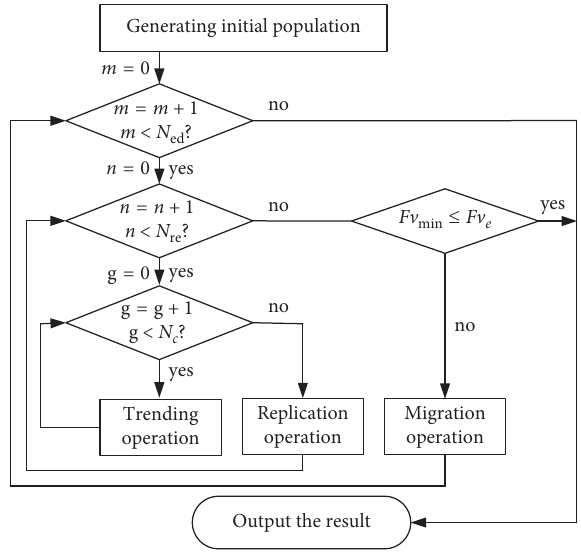
Figure 2: BFOA optimization